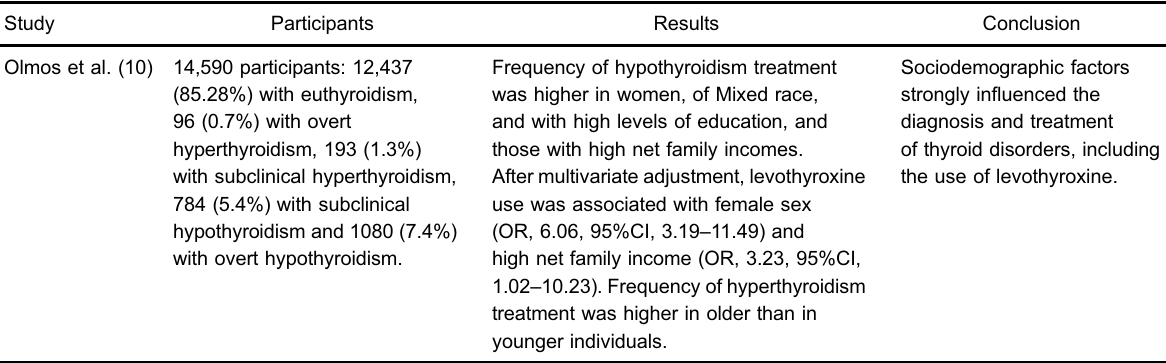
Table 2. Studies published with data from ELSA-Brasil included in this